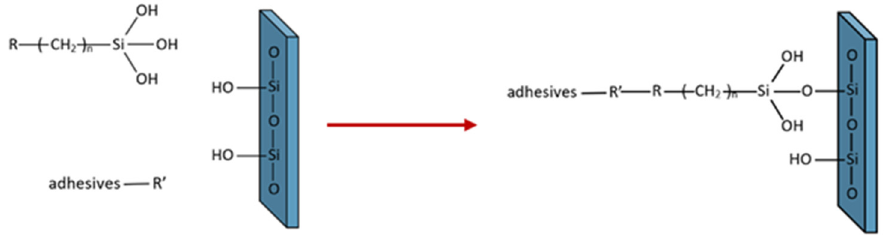
Figure 1. Illustration of a silane coupling agent forming a chemical bond between inorganic and organic substrates. organic